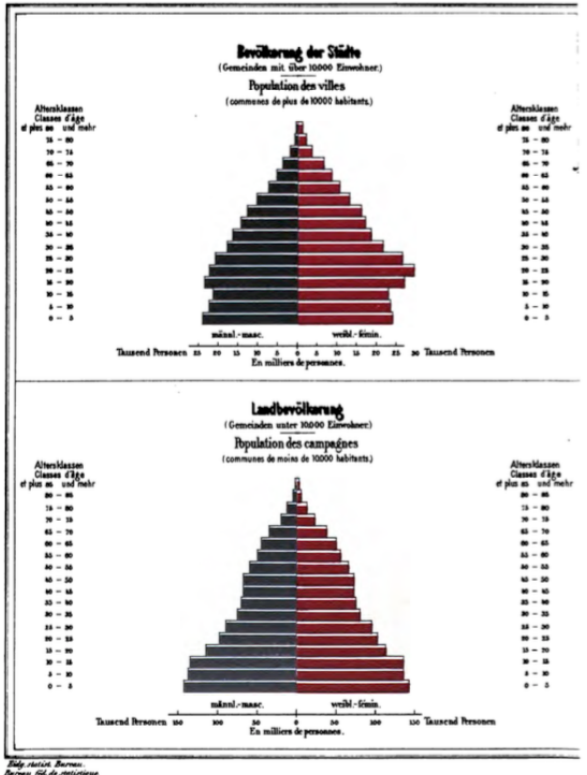
Figure 2: Age pyramids for urban (top) and rural (bottom) areas (Page 138, Graphisch-statistischer Atlas der Schweiz, 1897)